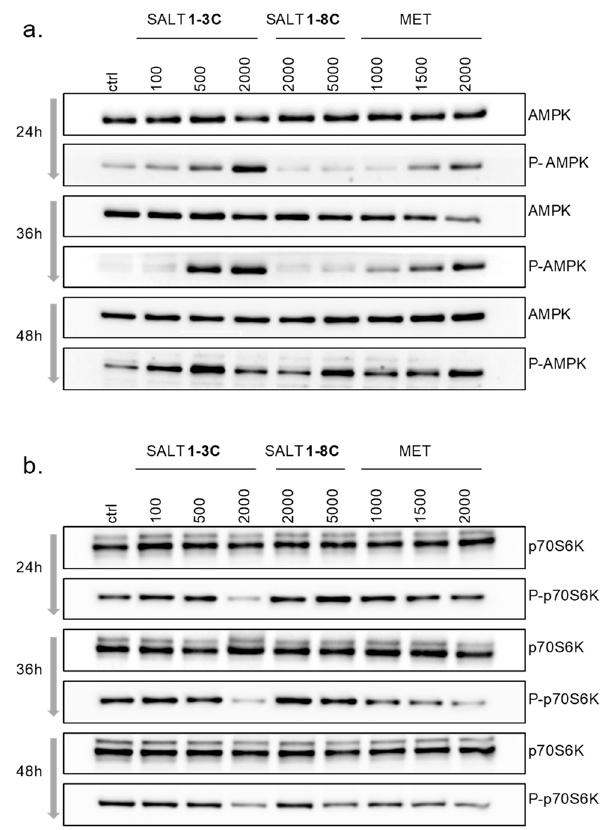
Figure 5. Salts 1- 3C and 1- 8C induce metabolic stress. Western blots of lysates prepared from A-375 cells treated with the indicated concentrations (nM) of salt 1- 3C , salt 1- 8C, or metformin for 24, 36, and 48 h. Metformin (MET) served as the positive control. ( a ) Detection of AMP-activated protein kinase (AMPK) and (Thr172) phosphorylated AMPK (P-AMPK). ( b ) Detection of p70S6K and (Ser434) phosphorylated p70S6K (P-p70S6K).